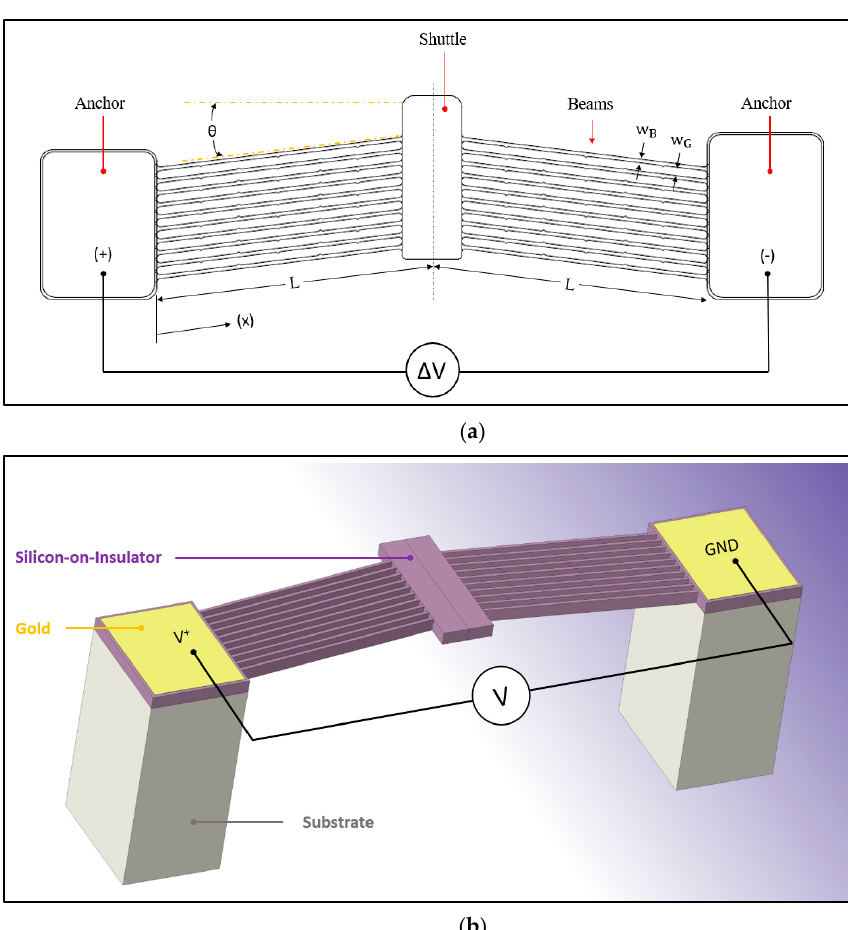
Figure 2. ( a ) A 2-dimensional plan representation of a V-shaped ETA. ( b ) A 3-dimensional view of a V-shaped ETA. Note that the silicon oxide insulating layer (between the silicon-on-insulator (SOI) and the substrate) is excluded from the schematic and simulations.